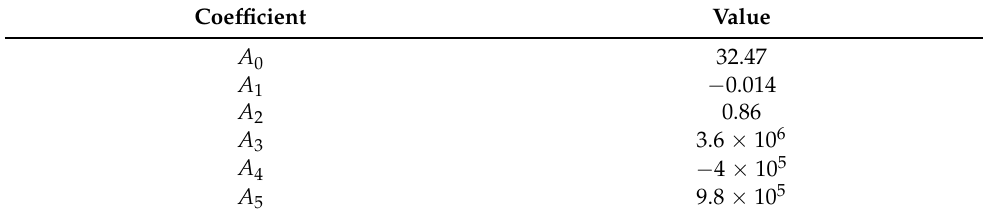
Table 3. Values of fuel consumption